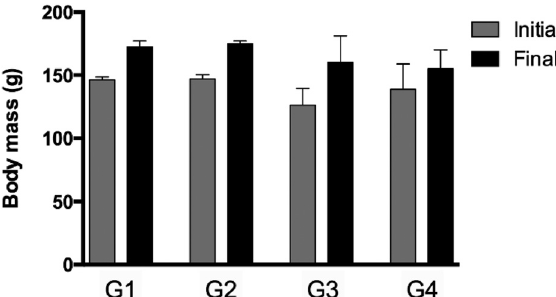
Figure 1 - Initial and fi nal body mass (g) of non-exercised and exercised rats supplemented or not with coconut oil. Data shown as mean ± standard error. G1 = Sedentary and Non-supplemented (Control Group), G2 = Sedentary and Supplemented Group, G3 = Physical Exercise and Non- supplemented Group, and G4 = Physical Exercise and Supplemented Group. Non-signi fi cance (ANOVA followed by Holm-Sidak